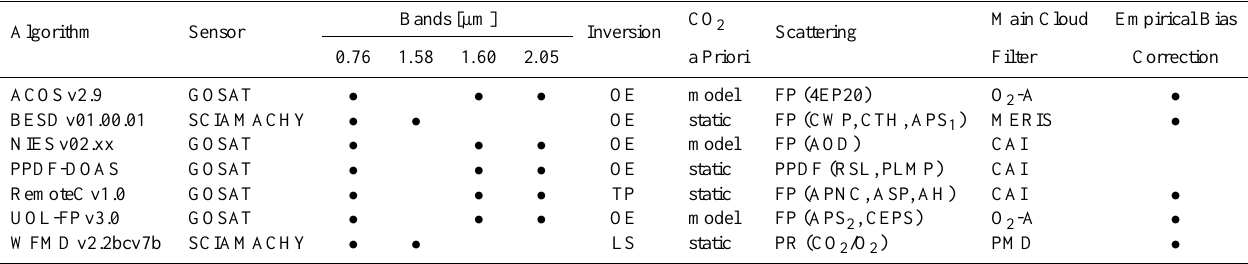
Table 1. Main retrieval characteristics: algorithm name and version, satellite instrument, spectral bands, inversion technique (OE = optimal estimation, TP = Tikhonov–Phillips regularization, LS = least squares), consideration of scattering (FP = full physics, PR = light path proxy, PPDF = photon path length probability density function, 4EP20 = 4 extinction profiles with 20 layers (two aerosol types, water and ice cloud), CWP = cloud water path, CTH = cloud top height, APS x = aerosol profile scaling of x different aerosol types, AOD = aerosol optical depth, RSL = reflectivity of scattering layer, PLMP = path length modification parameter, APNC = aerosol particle number concentration, ASP = aerosol size parameter, AH = aerosol height, CEPS = cloud extinction profile scaling), main cloud filter (MERIS = medium resolution imaging spectrometer, CAI = cloud and aerosol imager of GOSAT, PMD = polarization measurement device of